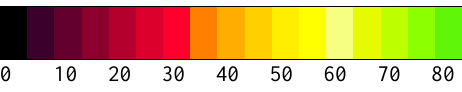
Fig. 11. The correspondence between percentage of individual magnetic scale lengths larger than 429km (vertical axis), UVI- inhomogeneities (horizontal axis), and the differences between the two conductance sets (color bar). The data points assigned non- uniform conditions are marked by crosses. To fulfill the first two selection criteria, the data points must be above the dotted horizon- tal line at 70% (selection criterion No. 1) and the left side of the dotted vertical line at 100% (selection criterion No. 2). The thick horizontal lines through three of the boxes indicate the data points which do not fulfill selection criterion No. 3.